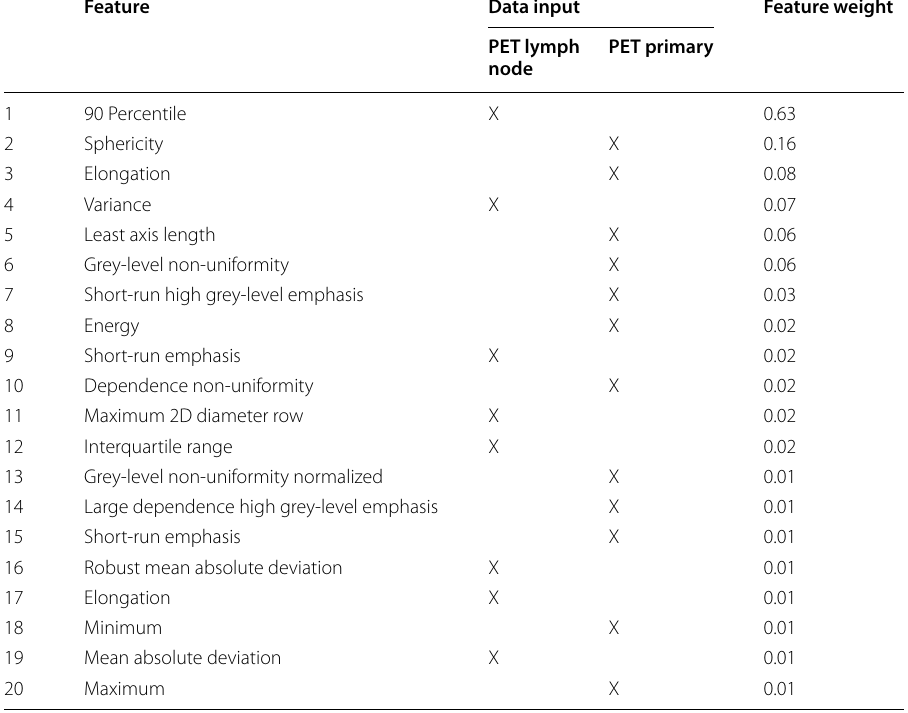
Table 3 Overview of the top 5, top 10, and top 20 best-performing features and the permutation feature importance